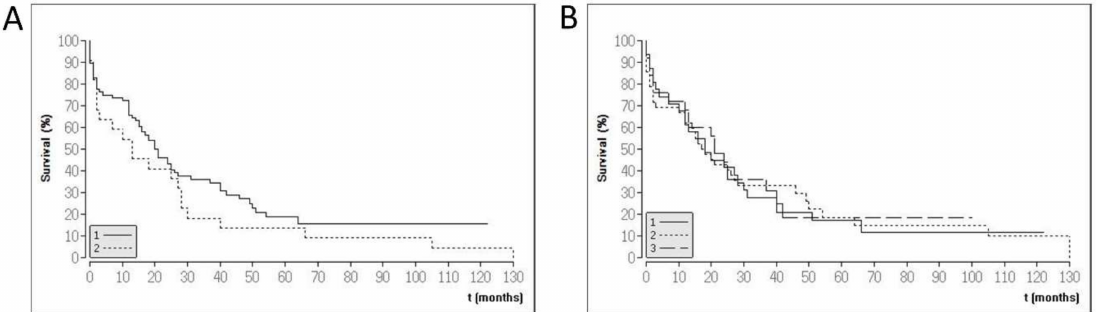
Figure 1. Kaplan–Meier graphs of the study population. ( A ) Survival data for moderate (group 1: UICC stadium I and II) and advanced (UICC stadium III and IV) cholangiocarcinoma (CCA) patients. ( B ) Survival data according to CCA location in the biliary tree (1: intrahepatic CCA, 2: perihilar CCA, 3: distal